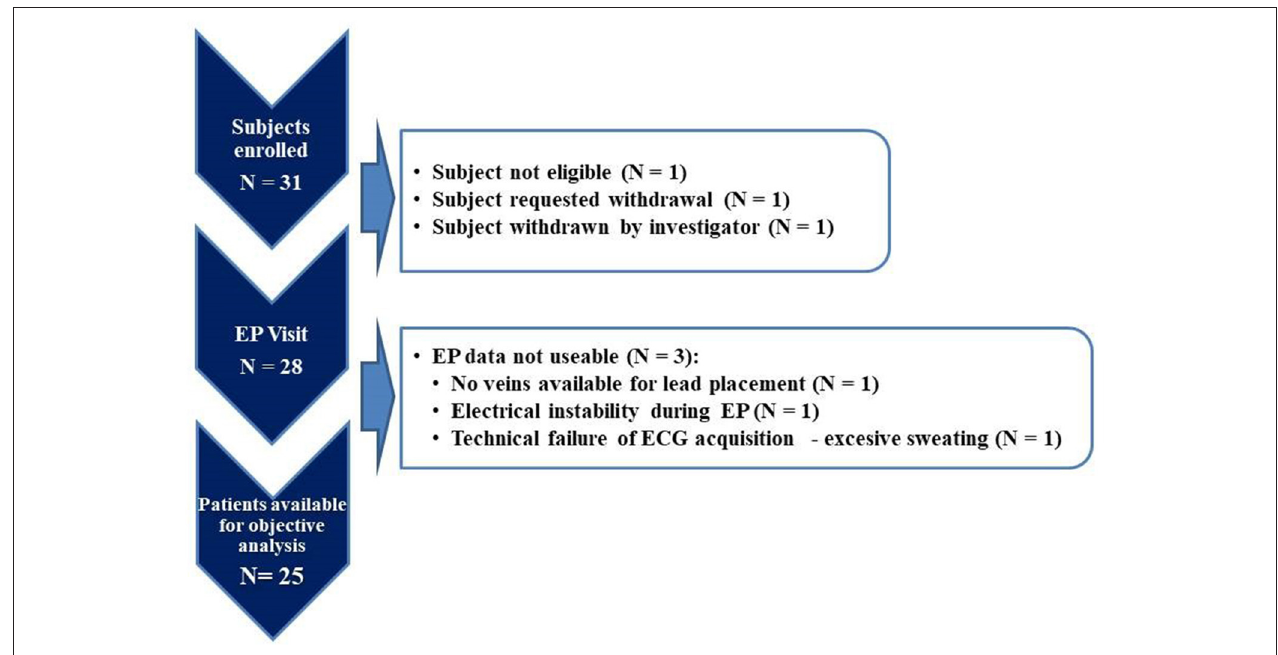
FIGURE 2 | SYNSEQ study